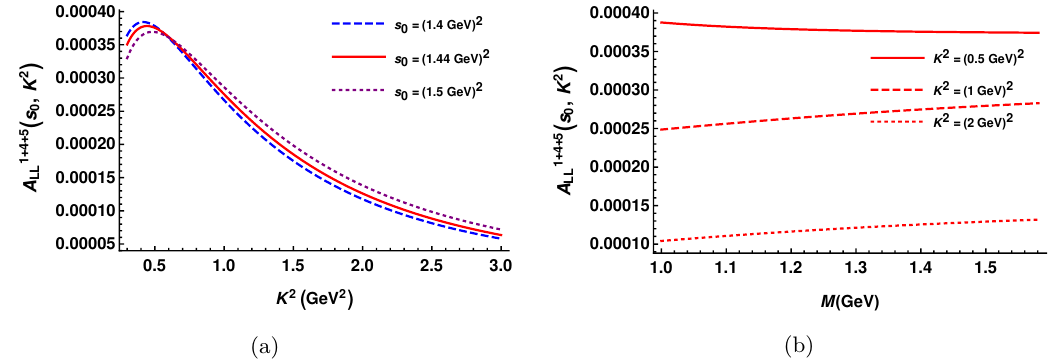
, F 4 and Figure 8 . The physical FF, A LL ( s 0 , K 2 ) is calculated from the combination of F 1 LL LL employing proton DAs. Left panel: A 1+4+5 ( s = 2 ) vs K 2 is shown for three values of s F 5 0 , K 0 LL LL (1 . 4 GeV ) 2 (violate dotted), s = (1 . 44 GeV ) 2 (red solid) and s = (1 . 5 GeV ) 2 (blue dashed) at 0 0 the Borel Mass, M 2 = 2 GeV 2 . Right Panel: A 1+4+5 ( s 2 ) vs M is shown for three values 0 , K LL of K 2 = 0 . 5 GeV 2 (red solid), K 2 = 1 GeV 2 (red dashed) and K 2 = 2 GeV 2 (red dotted) at the continuum threshold, s = (1 . 44 GeV ) 2 0